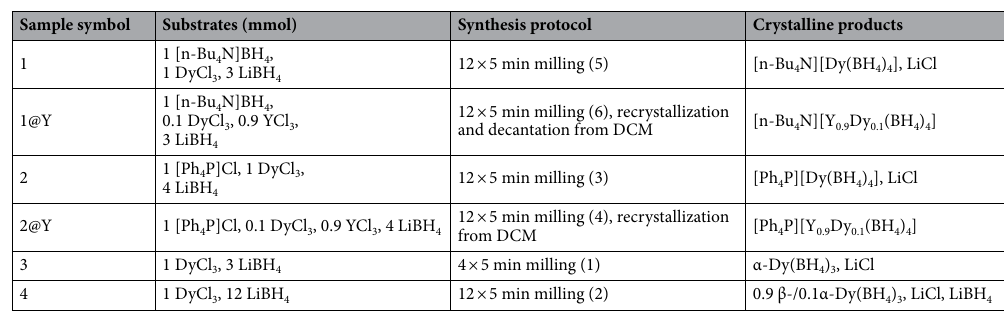
Table 1. Chemical composition of described compounds, their synthesis protocols, and used